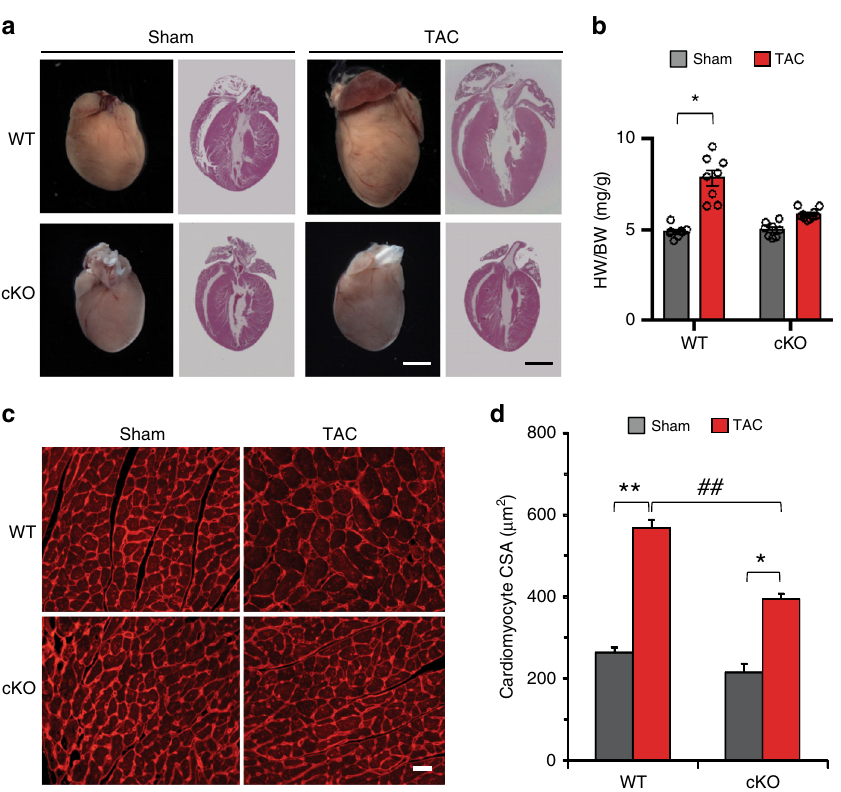
Fig. 4 FoxO1 is required for pathological cardiomyocyte growth. a Male mice of respective genotypes, FoxO1-WT (WT) and FoxO1-cKO (cKO), were subjected to sham and TAC surgery. Whole mount (left) and histology (right) of representative 3-week post-sham and -TAC hearts are shown. Note that cardiomyocyte-speci fi c silencing of FoxO1 (cKO) blunted TAC-induced hypertrophic growth of heart (bar = 2 mm). b Heart weight (HW)/body weight (BW) ratios indicate robust cardiac hypertrophy in WT ( n = 16) mice 3-week post-TAC, which is attenuated in cKO mice ( n = 18). * p < 0.001 vs sham. c , d Immunohistochemistry ( c ) and quantitation ( d ) of cross-sectional area (CSA) of cardiomyocytes of WT and cKO mice after 3-week sham and TAC surgery ( n = 3). Data are depicted as mean ± SEM. * p < 0.05 vs sham; ** p < 0.01 vs sham; ## p < 0.01 vs WT. Statistical analyses were conducted using a two-tailed, unpaired Student ’ s t